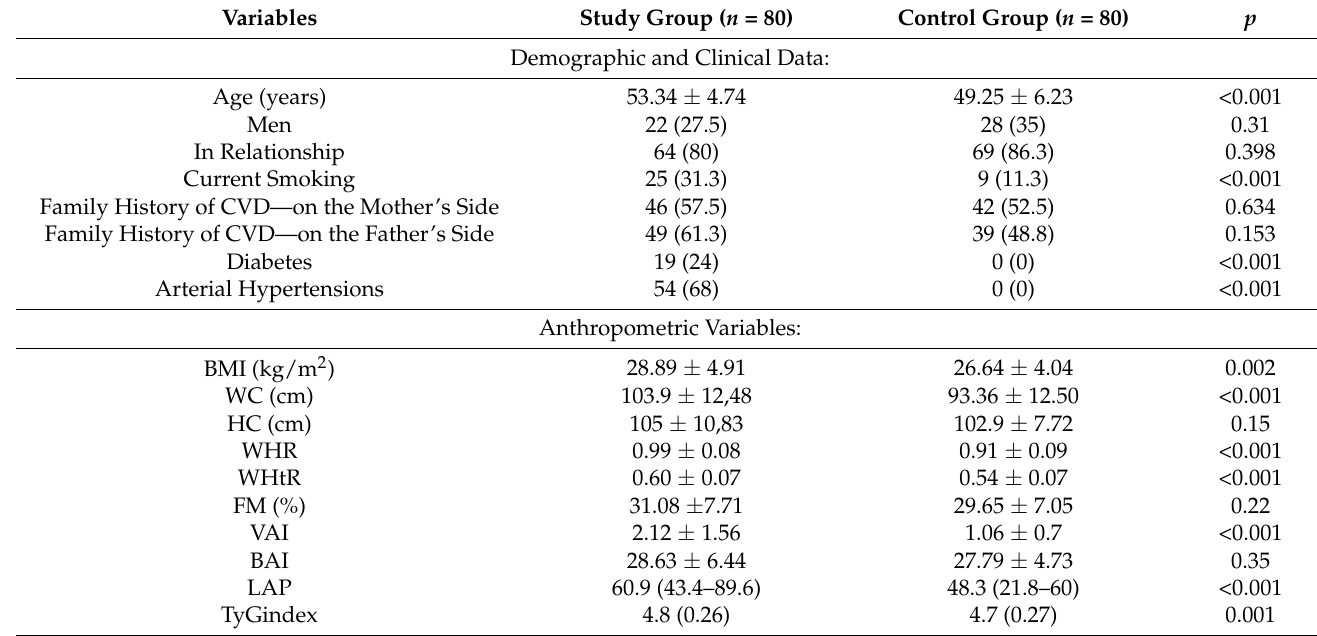
Table 1. Baseline demographics and clinical characteristics.